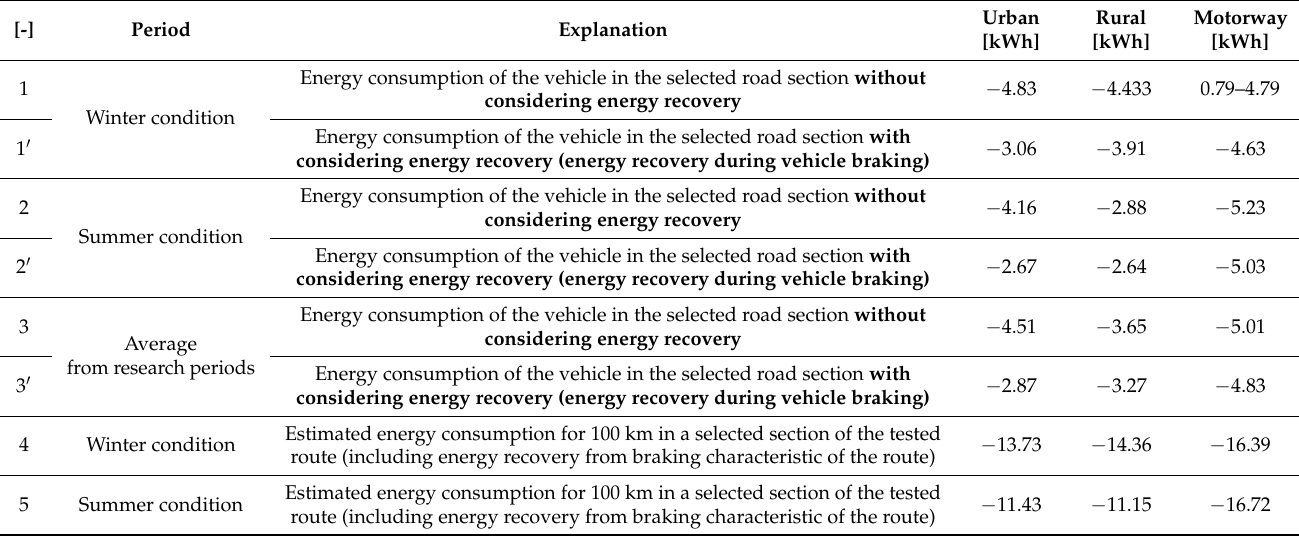
Figure 14. Energy flow characteristics and the share of energy consumption for different speed intervals in the RDC tests. Table 7. Energy consumption of an electric vehicle in the RDC test of Figure